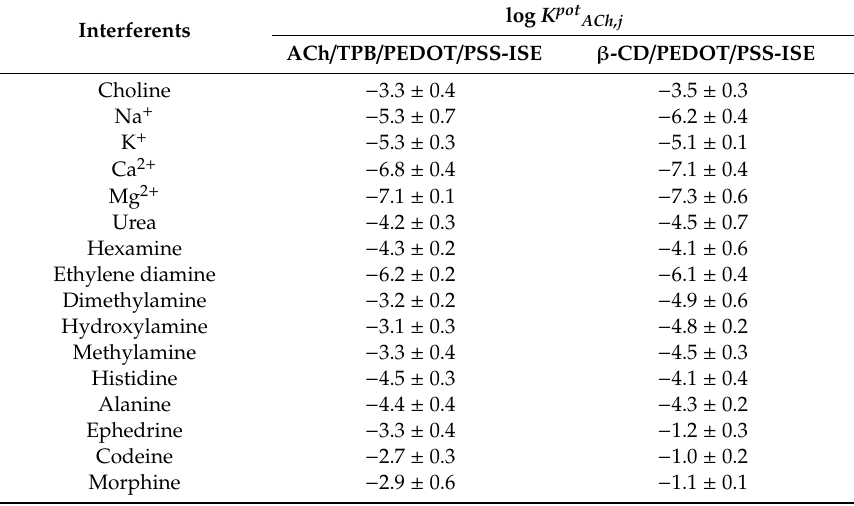
Table 3. Selectivity values ( K pot ACh,j ) for acetylcholine solid-contact